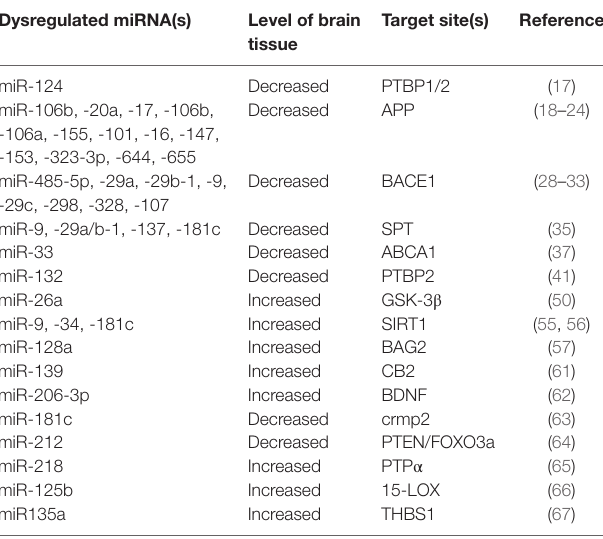
TABLe 1 | microRNAs (miRNAs) in Alzheimer’s